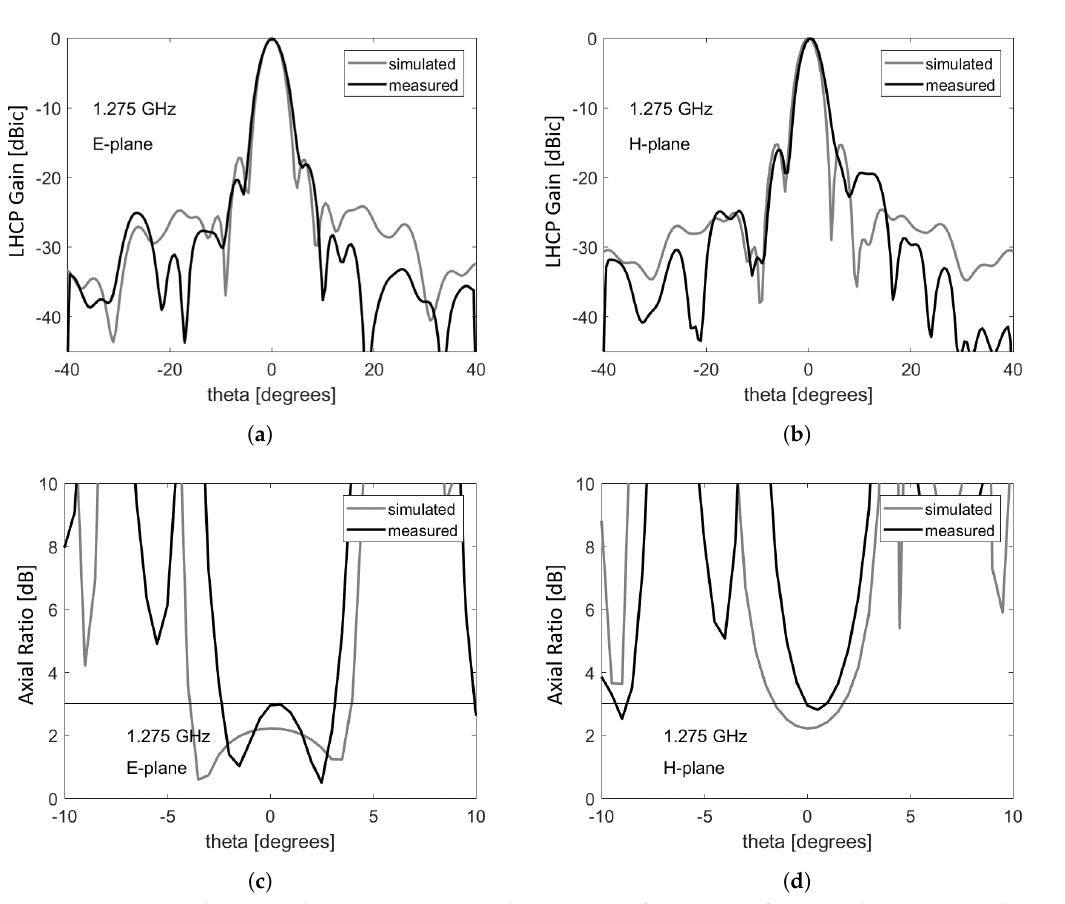
Figure 10. Simulation and measurement results at center frequency of RHCP directivity in the: ( a ) E-plane; ( b ) H-plane; and axial ratio in the: ( c ) E-plane; and ( d ) H-plane. Table 7. Summary of results of near-field antenna measurements at minimum , center, and maximum frequencies ( f min , f c , f max ) regarding: peak co-polarization at boresight (Co-pol), axial ratio (AR) at boresight, half-power beam width (HPBW), sidelobe levels (SLL) and cross-polarization at boresight